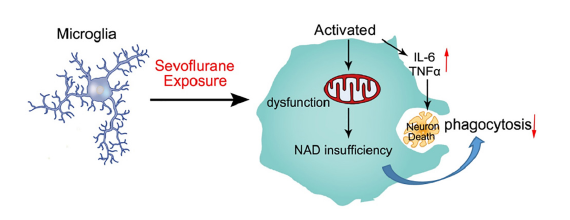
FIGURE6 Schematic diagram of sevoflurane-induced neurotoxicity by regulating the mitochondrial function of activated microglia due to NAD insufficiency. Microglia were activated by sevoflurane exposure and secreted proinflammatory factors to impair developing neurons. Mitochondrial function was also damaged after sevoflurane treatment, which could not produce sufficient NAD + to engulf neuron debris. The deficient phagocytosis of microglia resulted in apoptotic neuron